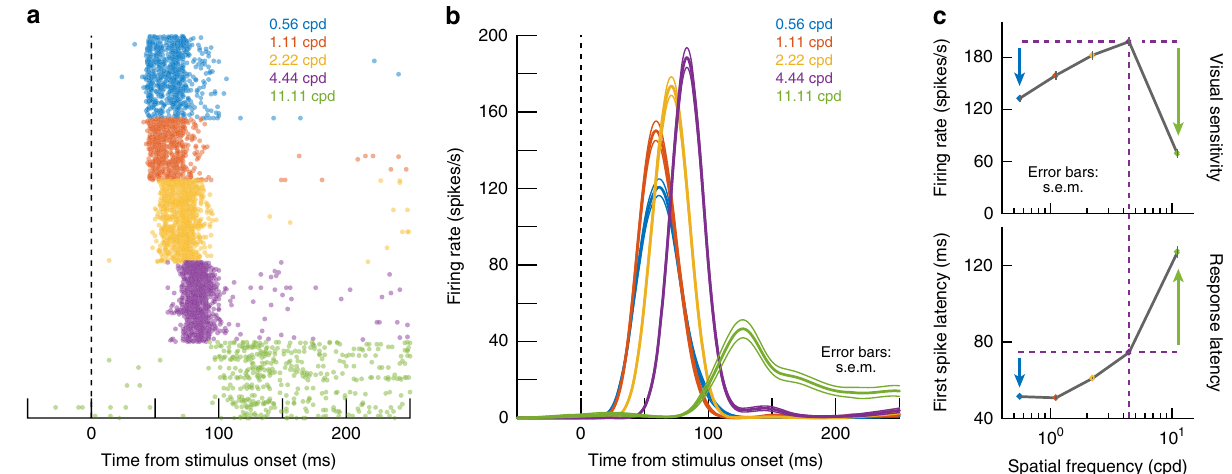
Fig. 1 Rapid primate superior colliculus (SC) detection of low spatial frequencies. a Visual responses of an example SC neuron to different spatial frequencies. Raster plots show times of individual action potentials with different trials from a given spatial frequency stacked in rows. Different spatial frequencies presented are color-coded in the fi gure, and they are only grouped here for easier visualization; spatial frequencies were randomly interleaved in the experiment itself. There was a rank ordering of response latency by the same neuron as a function of spatial frequency, with the lowest spatial frequencies (e.g. 0.56 and 1.11 cpd) evoking the shortest-latency neural responses. b The same neuron emitted the strongest visual responses for 4.44 cpd even though these strong responses came signi fi cantly later than for lower spatial frequencies. Thus, response latency and sensitivity were dissociated. c The top panel plots peak stimulus-evoked fi ring rate as a function of spatial frequency for the same neuron. Visual responses were strongest for 4.44 cpd. On the other hand, in the lower panel, latency to fi rst visually evoked spike at 4.44 cpd was longer than for lower spatial frequencies but shorter than for higher ones (e.g. colored arrows). Thus, there was a dissociation between neuronal response sensitivity and response latency. Error bars in b , c , when visible, denote